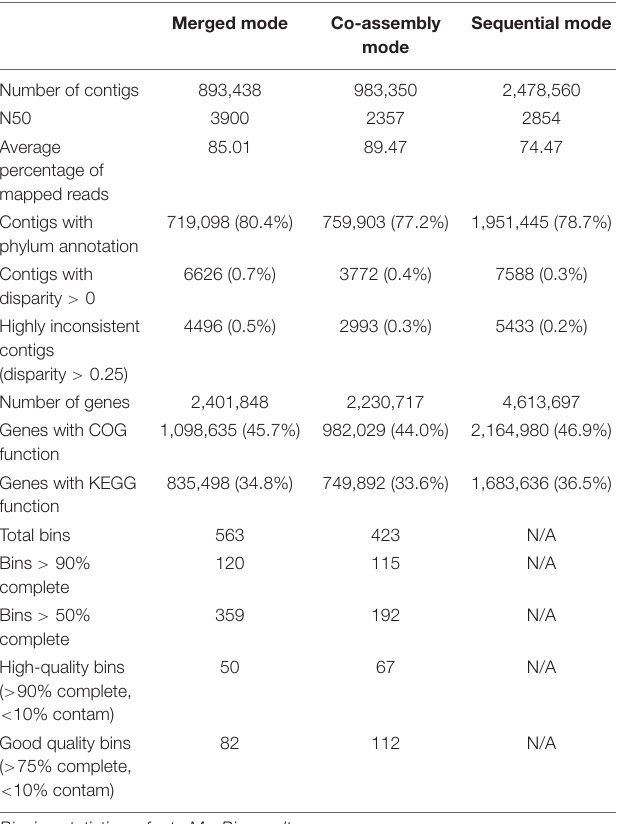
TABLE 2 | Statistics on contigs and bins for the three SqueezeMeta modes on Hadza & Italian